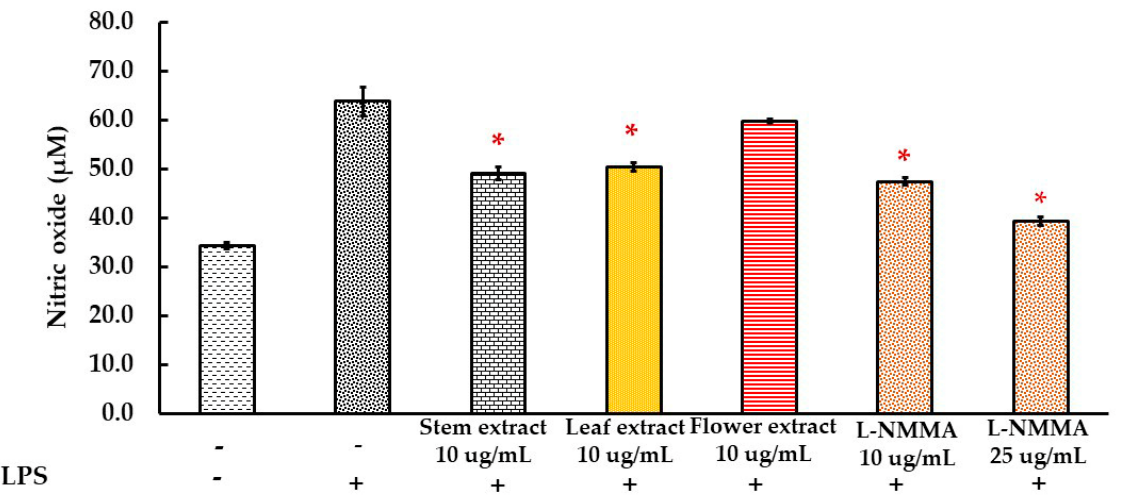
Figure 5. Effect of ethanolic extract of D. sulcatum stems, leaves and flowers (10 µg/mL) and L -NMMA (10 µg/mL and 25 µg/mL) on NO inhibition. Each value represents the mean ± SD, ( n = 3). * Significantly different versus the LPS-induced control at p < 0.05 Student’s t -test.